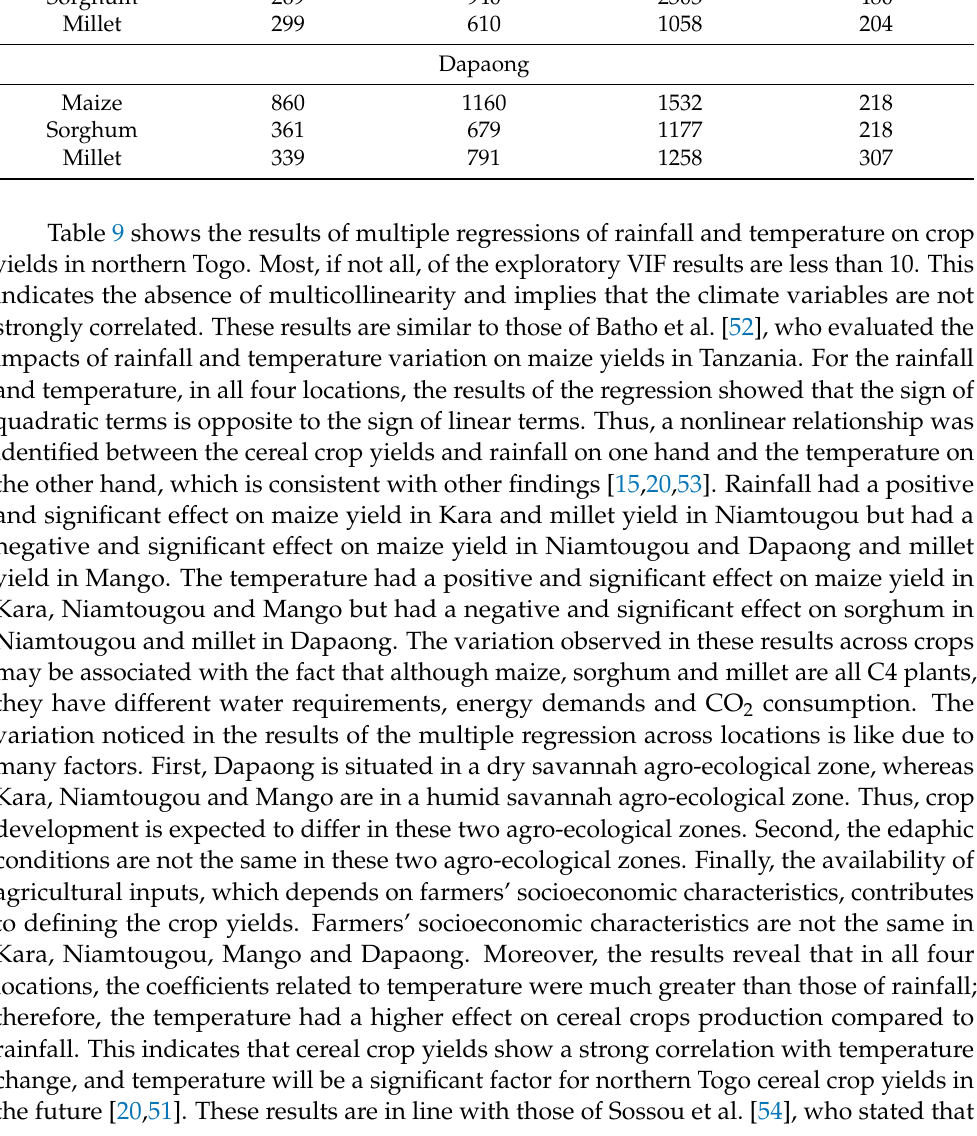
Table 8. Summary statistics of cereal yields in northern Togo from 1990 through 2012. Minimum Mean Maximum Standard Crops Deviation (Metric kg Per Hectare) Kara Maize 740 1226 2625 362 Sorghum 211 846 1438 327 Millet 135 399 807 160 Niamtougou Maize 665 1305 2123 325 Sorghum 692 1100 886 Millet 135 399 160 Mango Maize 533 1265 2041 334 Sorghum 269 940 2303 480 Millet 299 610 1058 204 Maize 860 Sorghum 218 Millet 339 791 1258